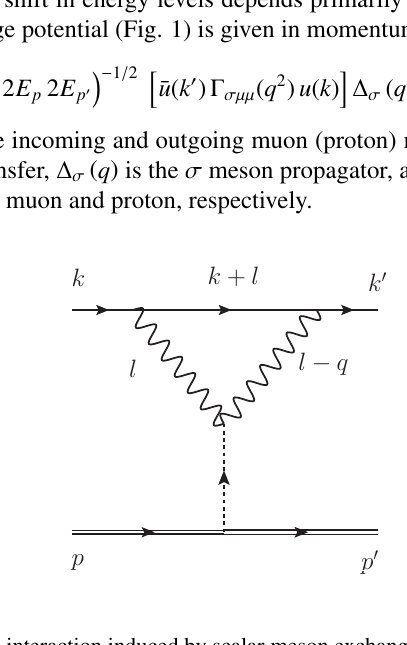
Figure 1. Muon-proton interaction induced by scalar meson